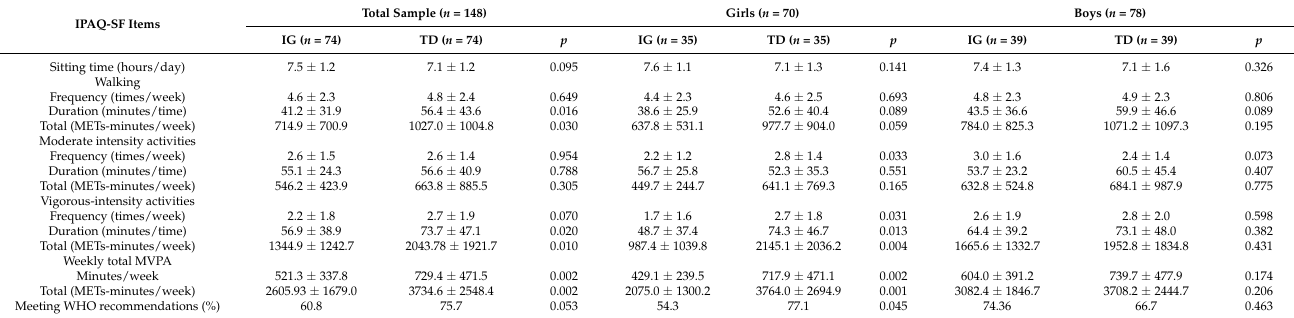
Table 1. Comparison of the physical activity and sedentary behavior levels of the